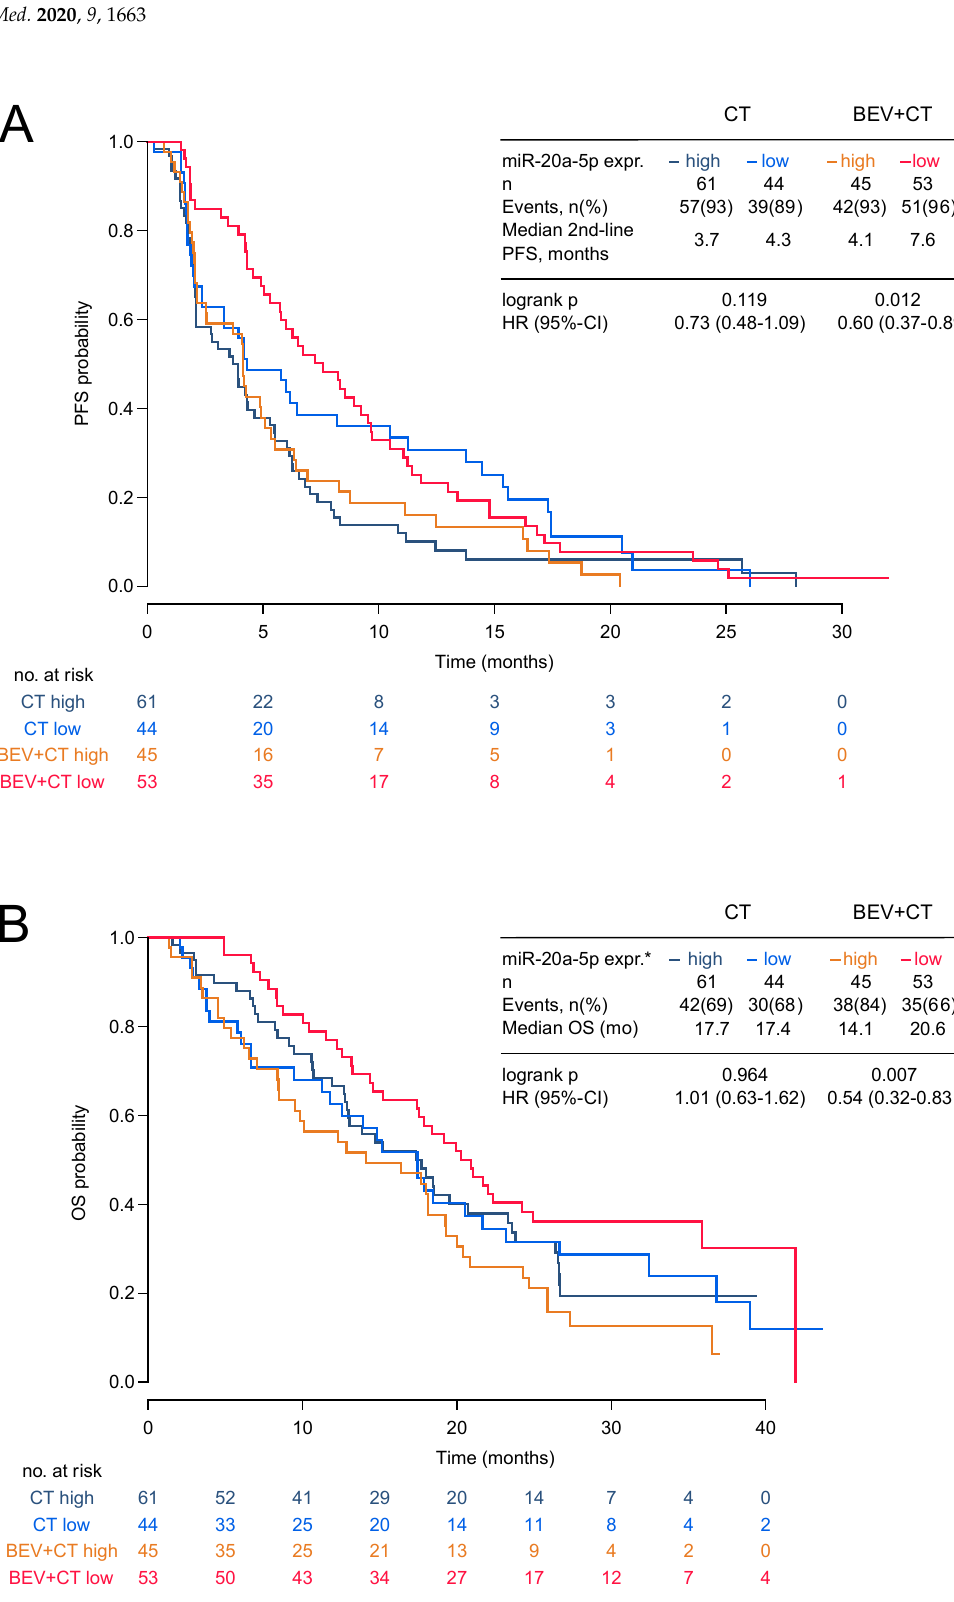
Figure 2. Second-line PFS and OS by miR-20a-5p expression in the TANIA phase III trial. Second-line PFS ( A ) and OS ( B ) by miR-20a-5p expression in the TANIA phase III trial (* high expression of miR-20a-5p was defined as Δ C T ≤ 3.775 and low expression as Δ C T > 3.775).